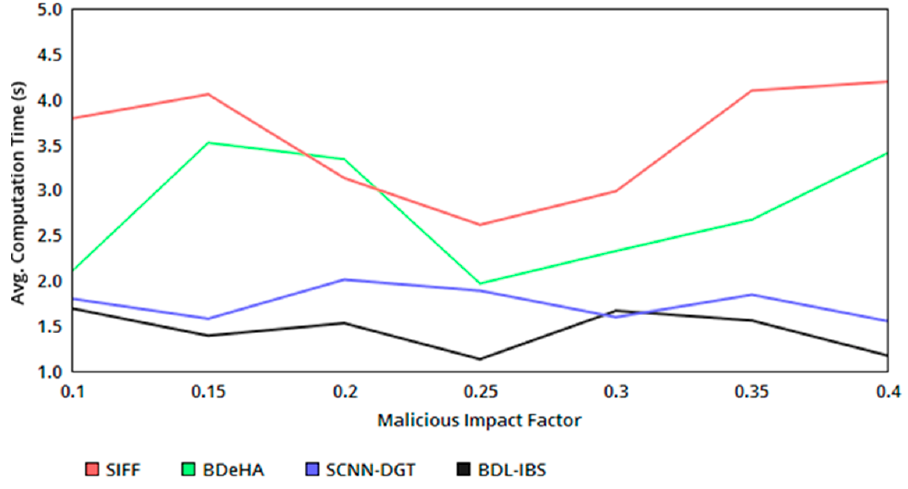
Figure 6. Avg. computation time versus malicious impact factor.